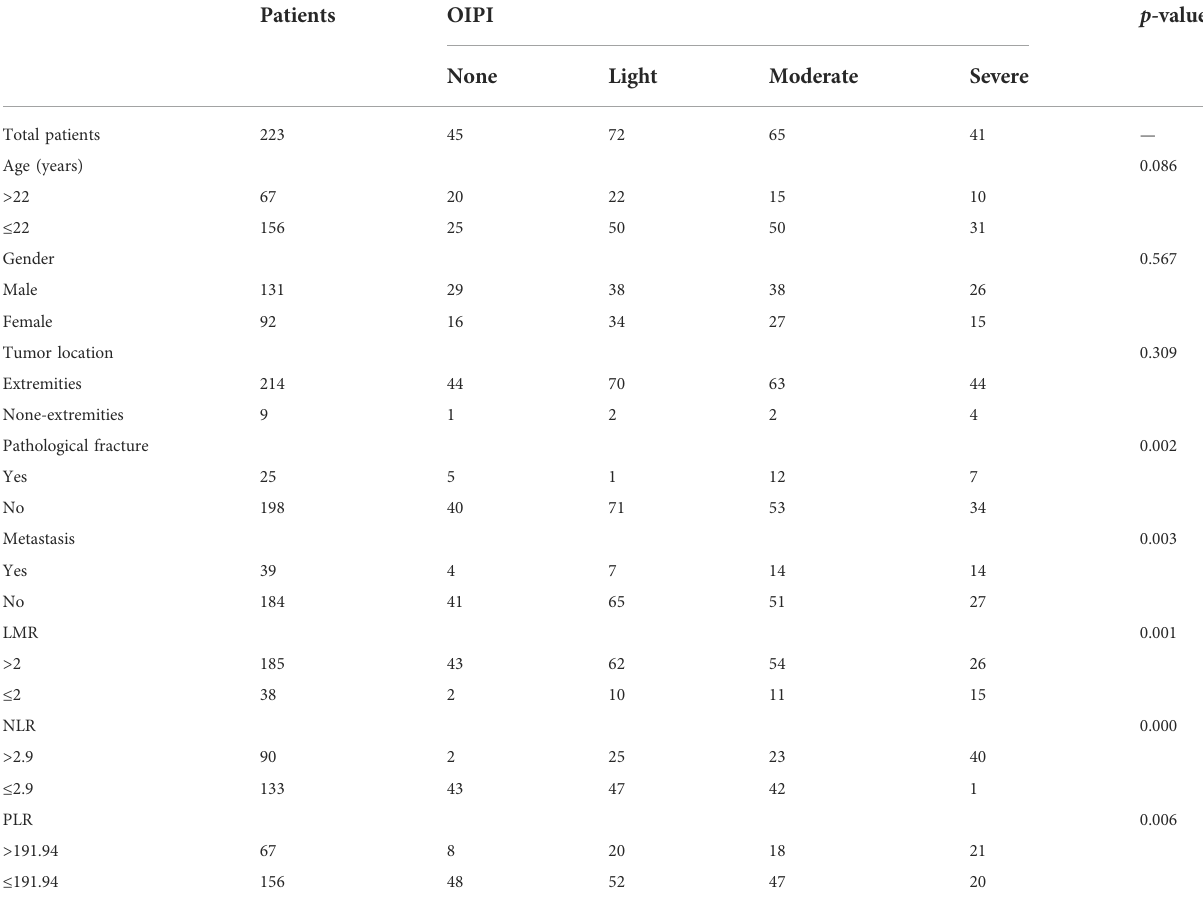
TABLE 1 Clinicopathological characteristics of